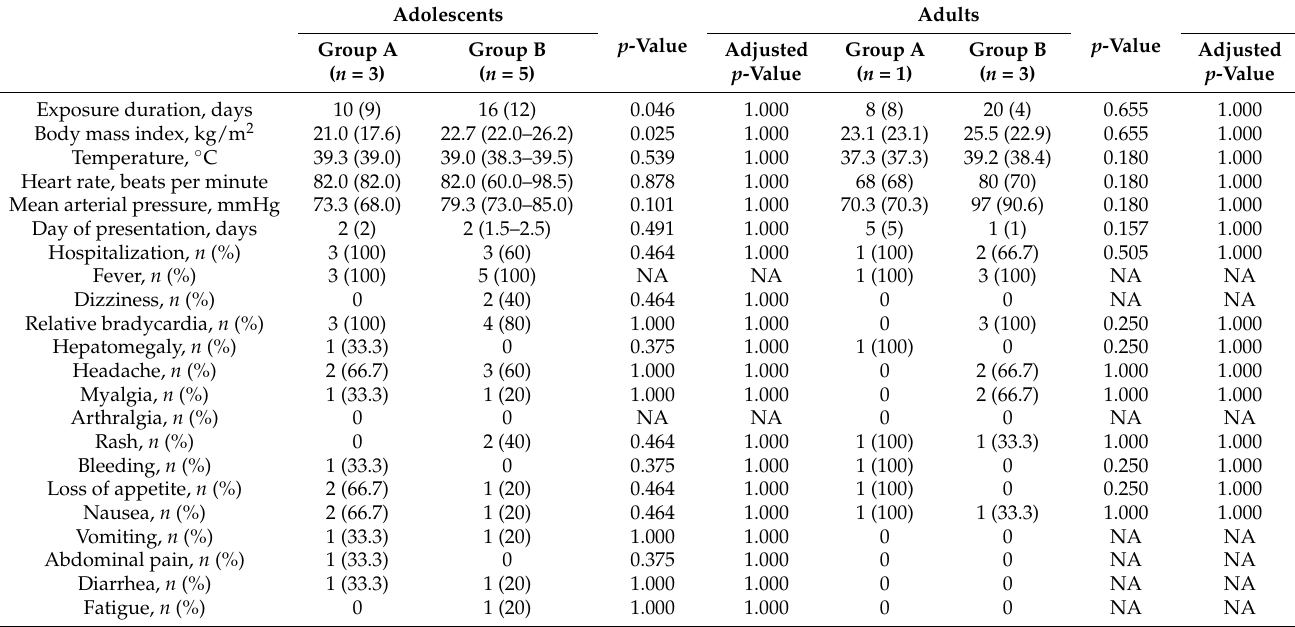
Table 1. Comparison of patients with and without dengue warning signs by age group.